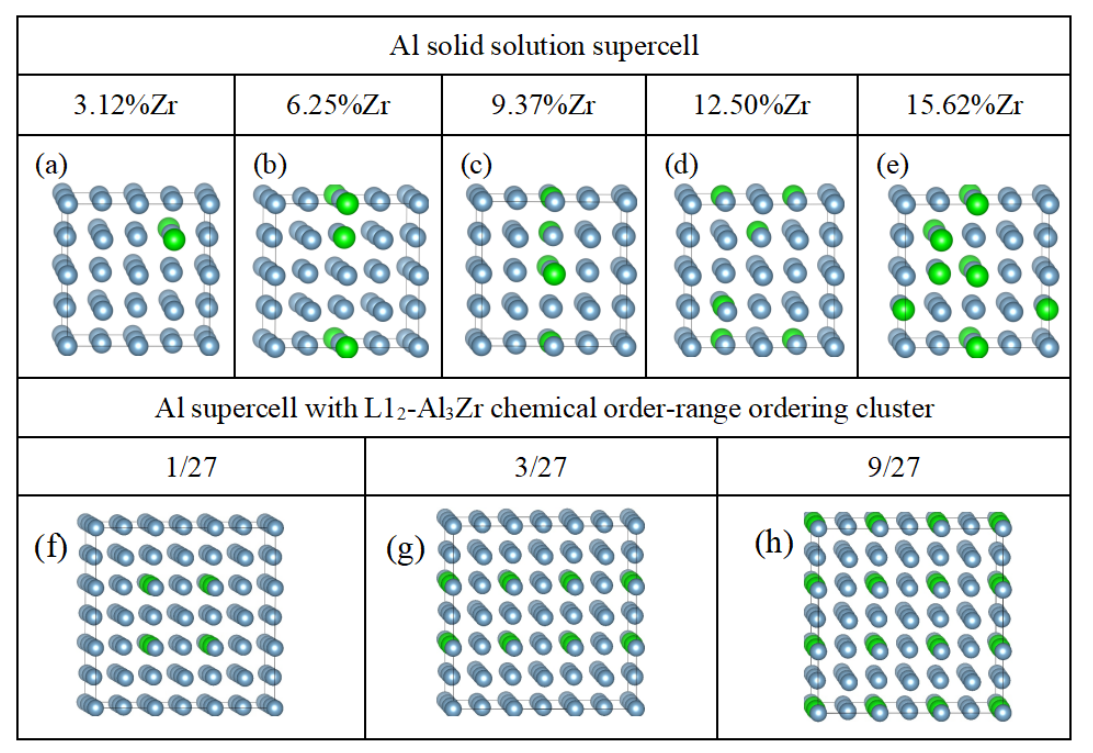
Figure 2. ( a – e ) The supercells of the Al solid solution with varied compositions of the solute atoms Zr before relaxing atoms and volumes and ( f – h ) Al supercells with the chemical short-range ordering clusters L1 2 -Al 3 Zr before relaxing atoms and volumes.